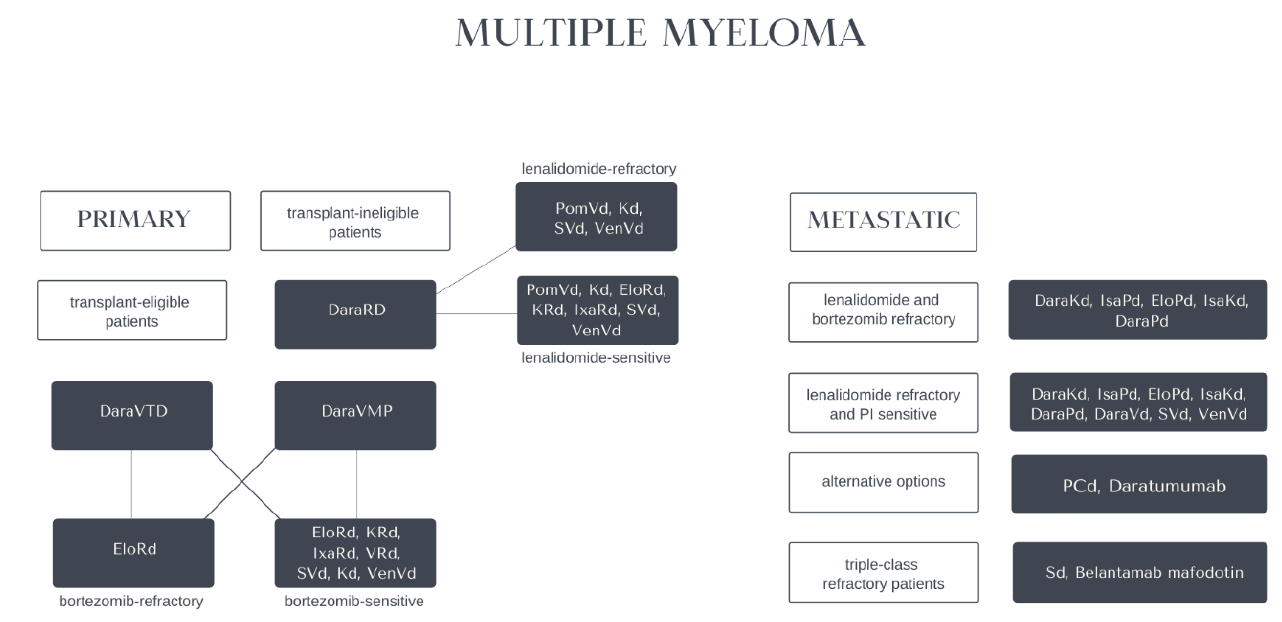
Figure 4. Scheme depicting the therapeutic strategies for patients with primary and metastatic multiple myeloma. Primary neoplasm is divided into transplant eligible and ineligible patients.